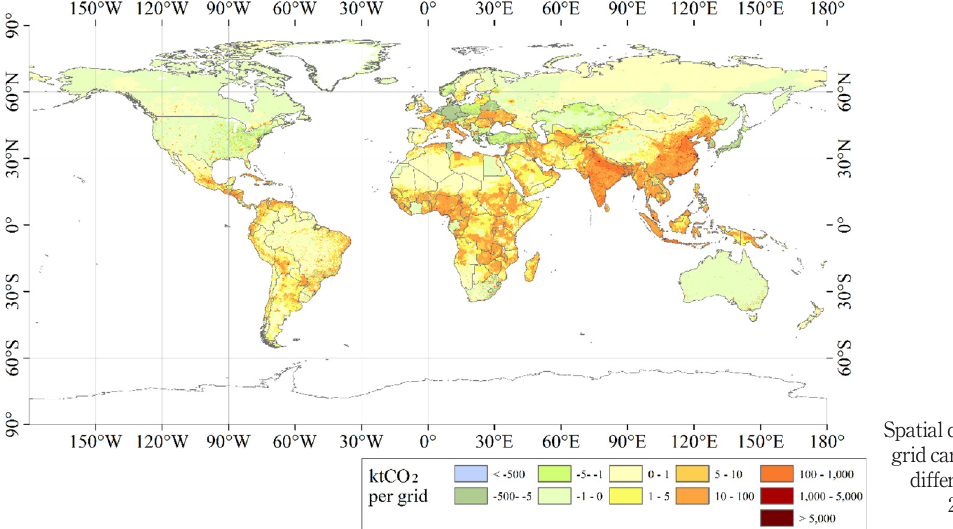
Figure 11. Spatial distribution of grid carbon emission difference